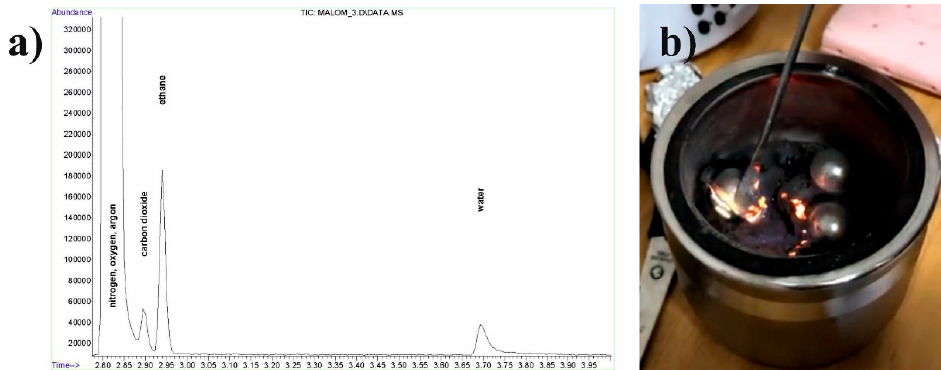
Figure 14. ( a ) Chromatogram of volatile substances in the milling bowl and ( b ) burning of ethane after Figure 14. Chromatogram of volatile substances in the milling bowl and burning of ethane after 30 h 30 h milling milling time.